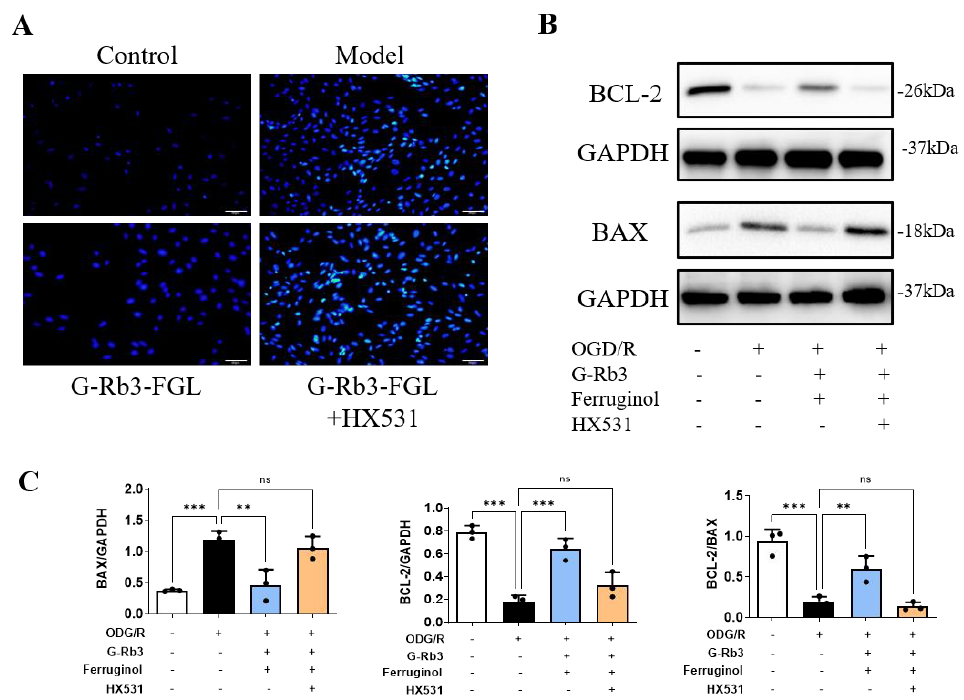
Figure 6. G-Rb3-FGL inhibits apoptosis via RXR α in vitro. ( A ) The results of Hoechst staining (×10). Blue fluorescence represents apoptotic cells. ( B , C ) Representative immunoblots and the quantification of Bax and Bcl-2 in different groups. N = 3 per group. ns No statistical significance, ** p < 0.01, *** p < 0.001 vs. model group.